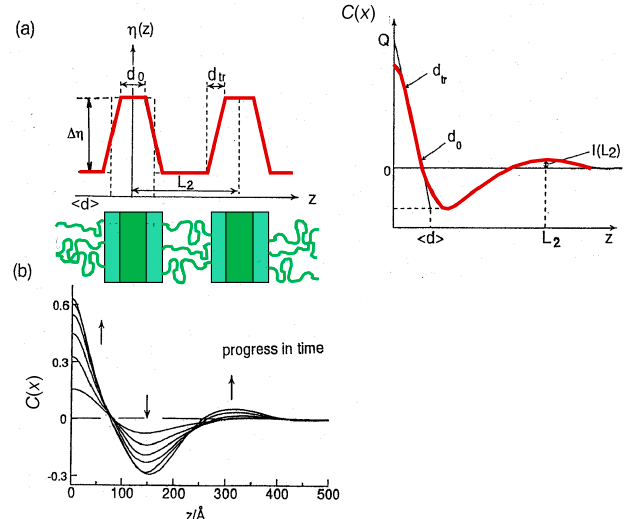
Figure 3. ( a ) Correlation function of the 1D stacked lamella structure and the relationship with the actual structural parameters and ( b ) the time dependence of the correlation function in the isothermal crystallization process of it